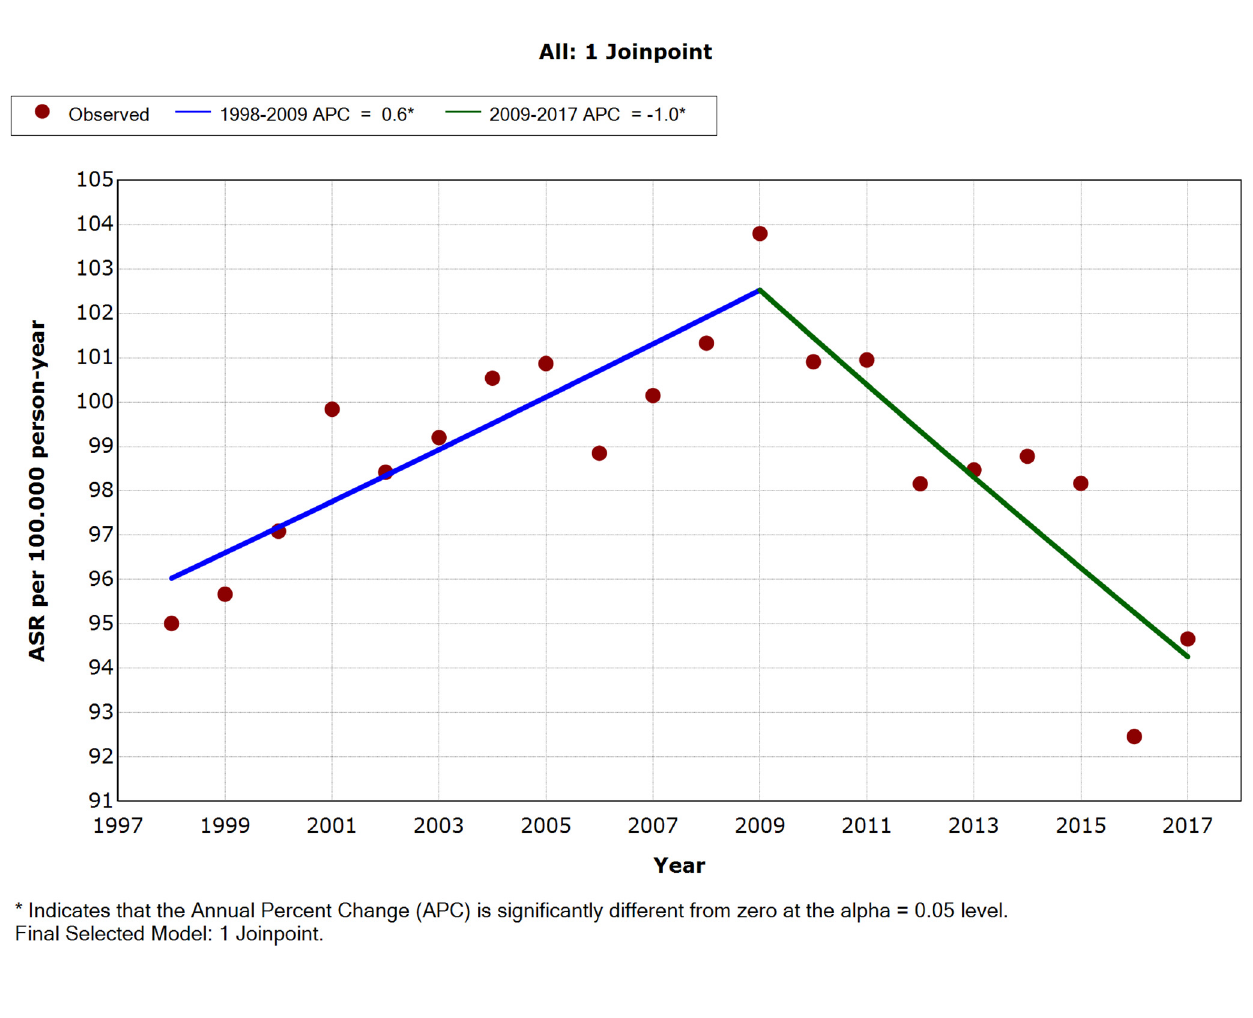
Figure 1. Annual age-standardized rate per 100,000 male (all ages), admitted for acute appendicitis in Spain, 1998 to 2017.